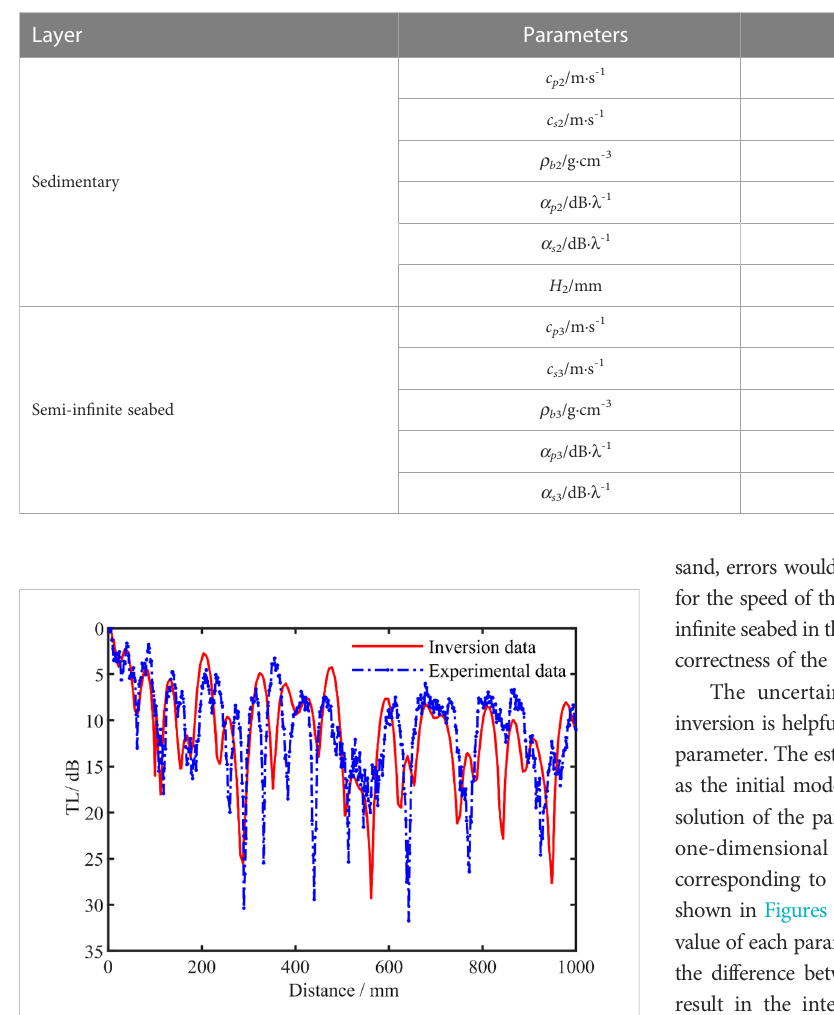
FIGURE 12 Comparison of the transmission loss between the measured (dashed blue trace) and the inversion data (solid red